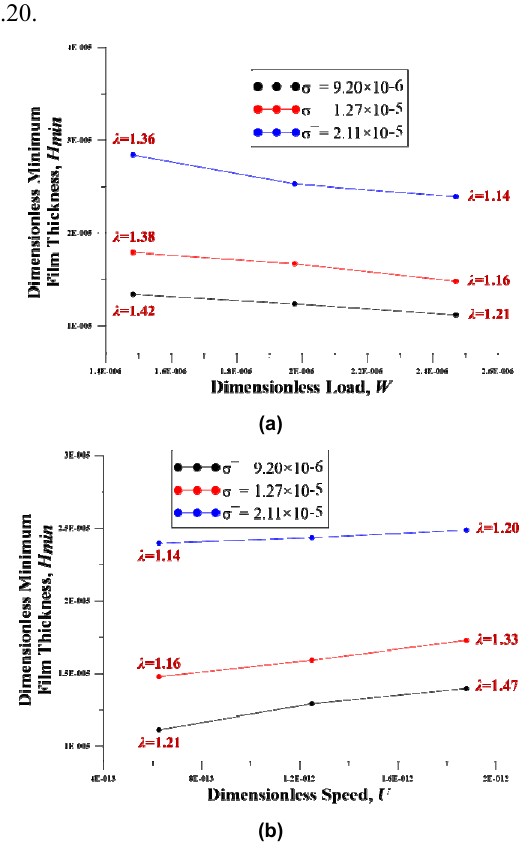
Figure 12. Effect of (a) dimensionless load (b) dimensionless speed on dimensionless minimum film